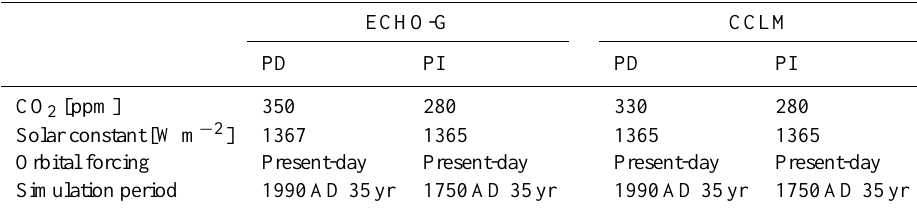
Table 1. Experiment setup for external forcing for the driving ECHO-G model and the regional climate model CCLM for the present day (PD) and pre-industrial period (PI). All simulations are carried out with constant forcing (quasi-equilibrium simulations).